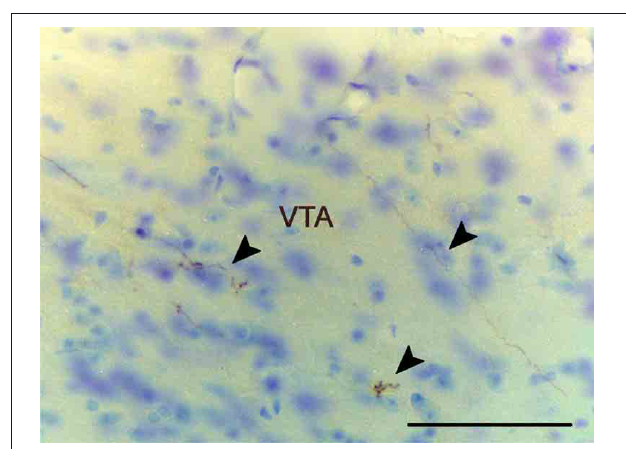
FIGURE 5 | Anterograde labeling in the hypothalamus following tracer injections in the medial amygdaloid nucleus. Photomicrographs of transverse sections through the hypothalamus of animals receiving tracer injections in the MeA (A,D) , MePD (B,E) , and MePV (C,F) . (A–C) Pattern of anterograde labeling in the ventromedial hypothalamic nucleus (VMH) in CD1 animals. Injections in MeA resulted in dense fiber labeling in the dorsomedial VMH (A) , whereas injection in MePD give rise to dense labeling in the ventrolateral VMH (B) . The MePV does not appear to